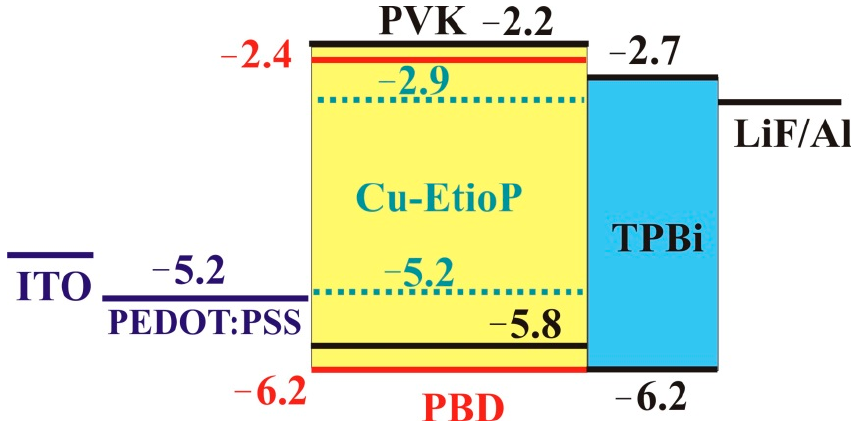
Figure 6. Energy diagram (eV) for the OLED studied with Cu-EtioP in the light-emitting layer.